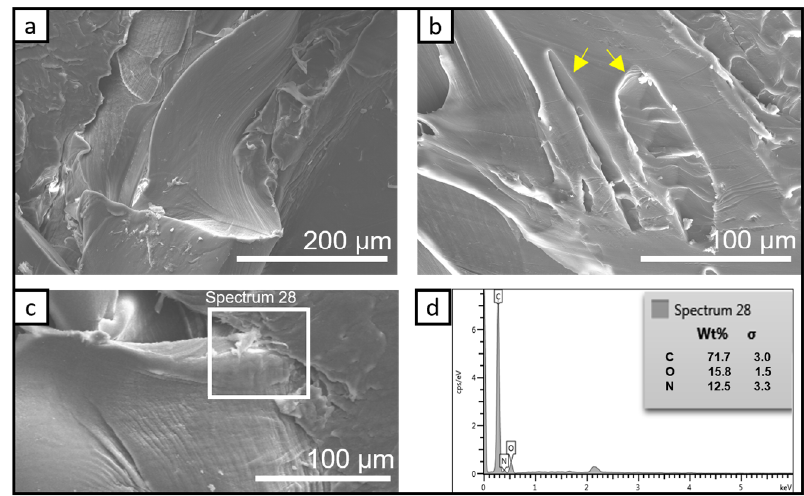
Figure 1. Representative SEM micrographs of bio-PA1010, reference sample: low magnification image showing the smooth surface and the demoulded area of the sample ( a ); detailed image of the technological cavities (marked in b ) with yellow arrows); the area selected for the EDS analysis ( c ); and the EDS spectrum and elemental composition of the selected area ( d ).